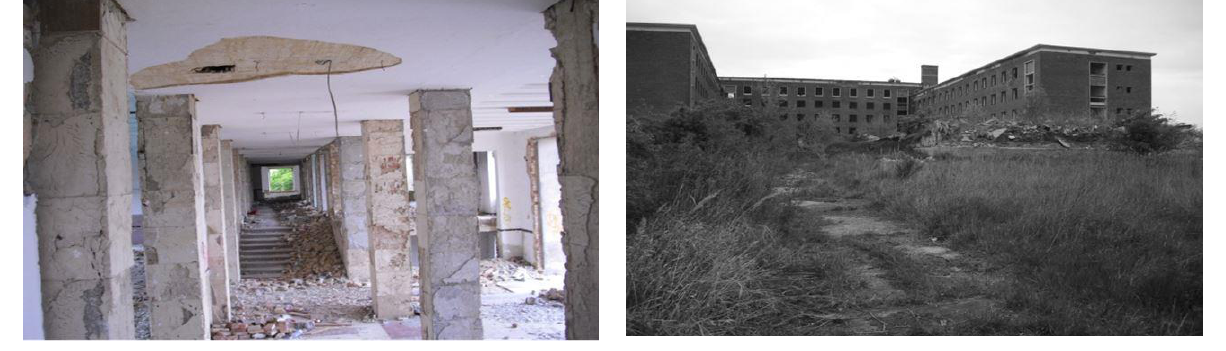
Fig. 6. Artillery Brigade of Pécs yard of the company block Fig. 5. Pécs, 101. „Szigetvári” Miklós Zrínyi Mixed Artillery Brigade “a corridor main building” (Photo made by author) Table 4. Excerpt of results of ground-water samples (Source: author’s edit based the results of Sevorg Kft.,